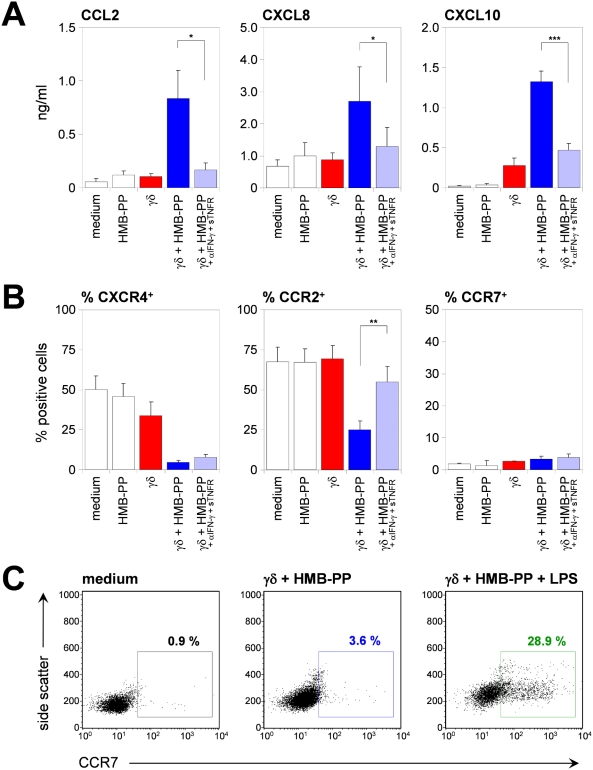
Vγ9/Vδ2 T cell-activated monocytes possess altered migratory properties.(A) Mean protein levels (pg/ml)±SEM of secreted CCL2, CXCL8, and CXCL10, and (B) mean percentages±SEM of CXCR4+, CCR2+, and CCR5+ monocytes after 18 hours of culture under the conditions indicated (n = 3–8). (C) Side scatter and CCR7 fluorescence for monocytes after 18 hours of culture in medium, or with γδ T cells+HMB-PP in the absence or presence of LPS; representative of two independently assessed donors.